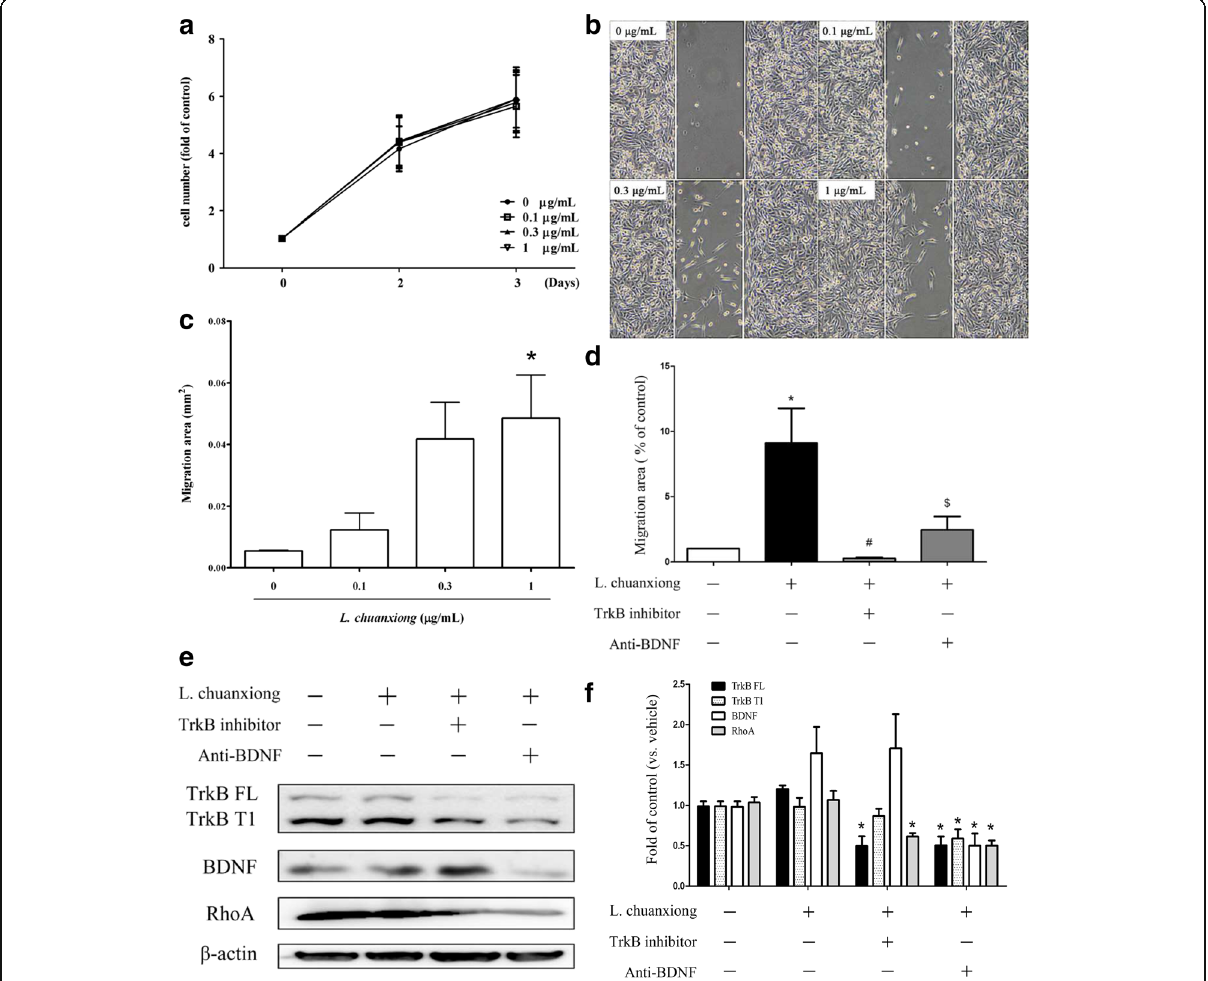
Fig. 6 The role of BDNF-TrkB signaling in the L. chuanxiong induced responses within MDA-MB-231 cells. L. chuanxiong -treated MDA-MB-231 cells, without/with anti-BDNF antibody and with/without TrkB inhibitor pretreatment independently were evaluated by MTT assay ( a ) and